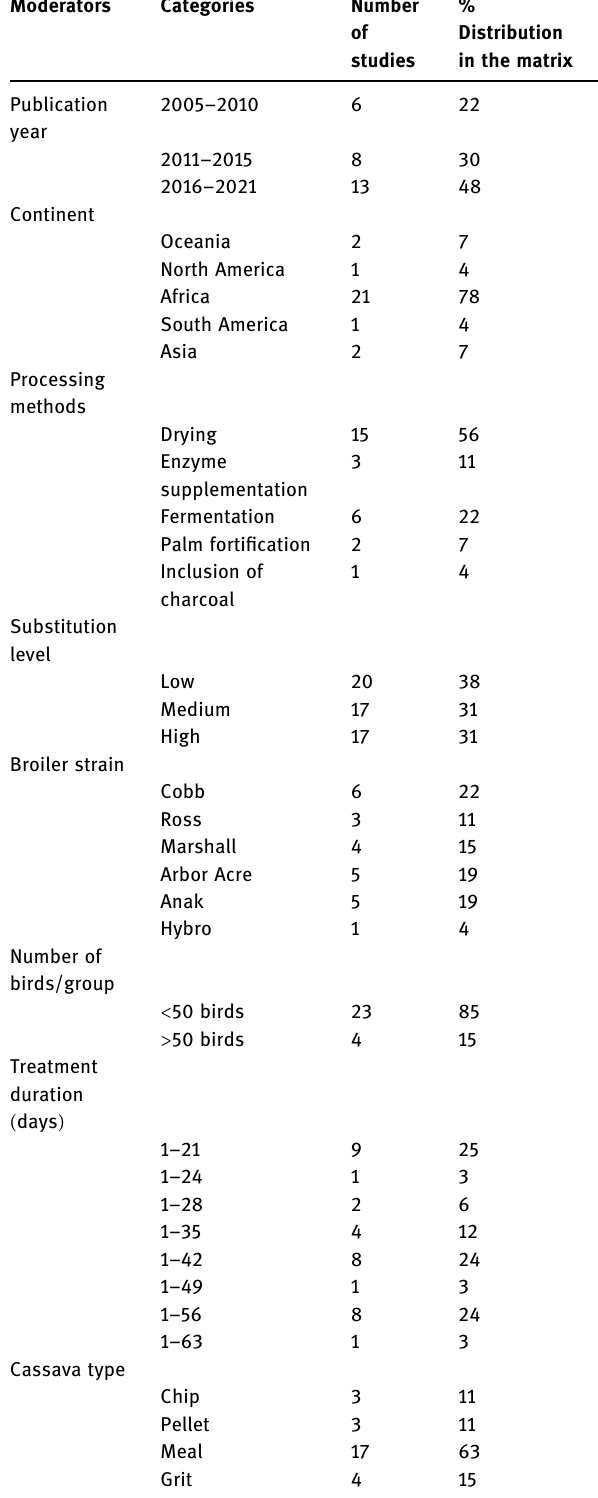
Table 2: Features of 27 studies included in the meta - analysis